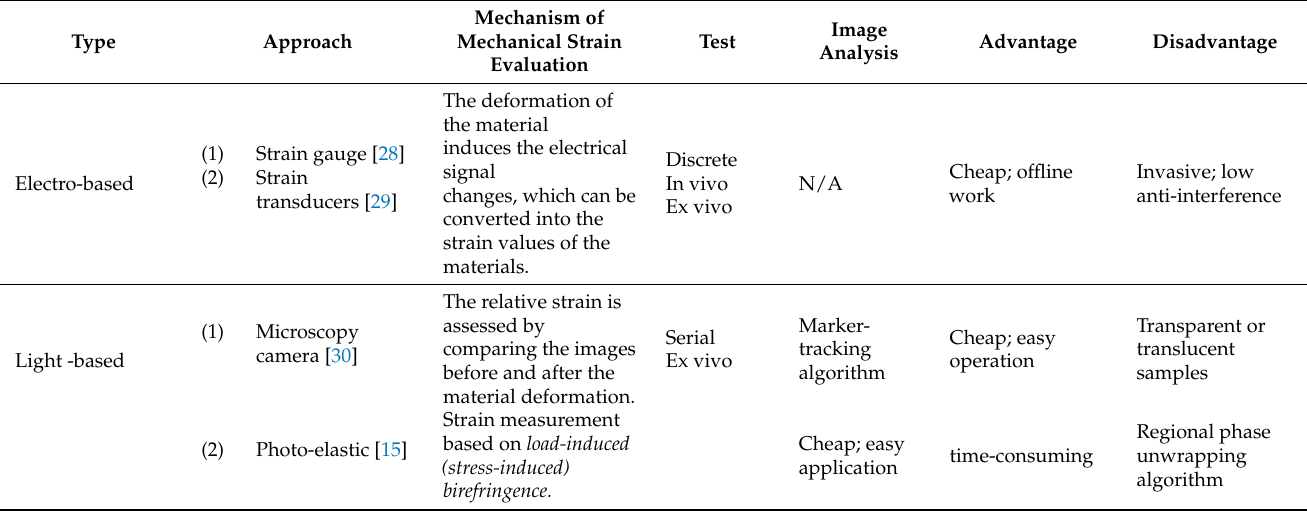
Table 1. Comparison of the strain measurements produced by different mechanisms and their possible